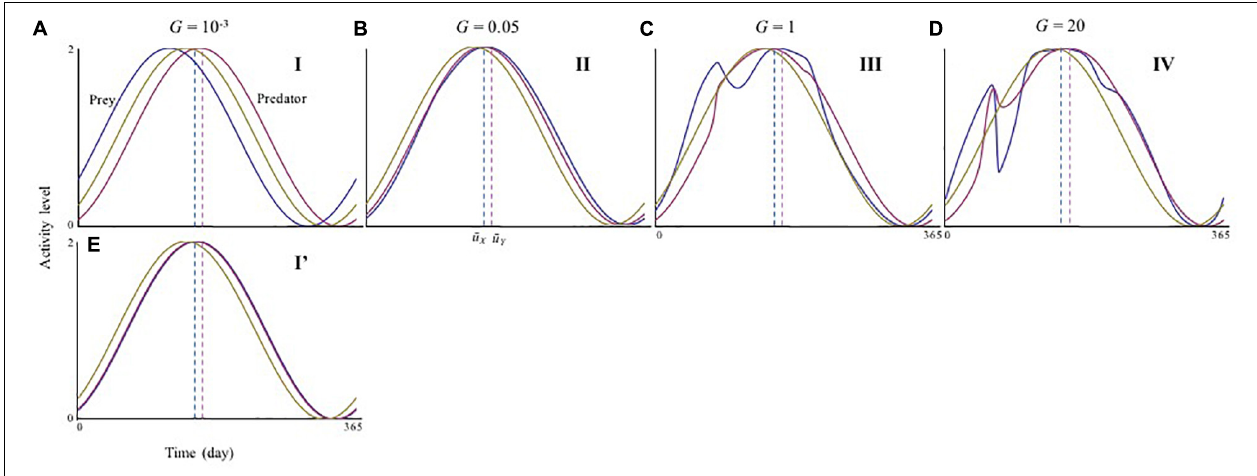
FIGURE 3 | Activity cycles with varying adaptation speeds. (A–E) is seasonal activity cycle in different speed of adaptation, which corresponds to distinct phases shown in Figure 2 . (A) G = 0.001 (phase I); (B) G = 0.05 (phase II); (C) G = 1 (phase III); (D) G = 20 (phase IV); and (E) G = 0.001 (phase I’). Yellow lines are the resource cycle. The blue and red dashed lines represent the physiological optimal activity peak timing and T ¯ U Y and T ¯ U X , respectively. The time range shown in the horizontal axes is from 5 × 10 5 – T to 5 × 10 5 (for convenience, the initial time is noted as 0). Parameters are the same as those of Figure 2 .